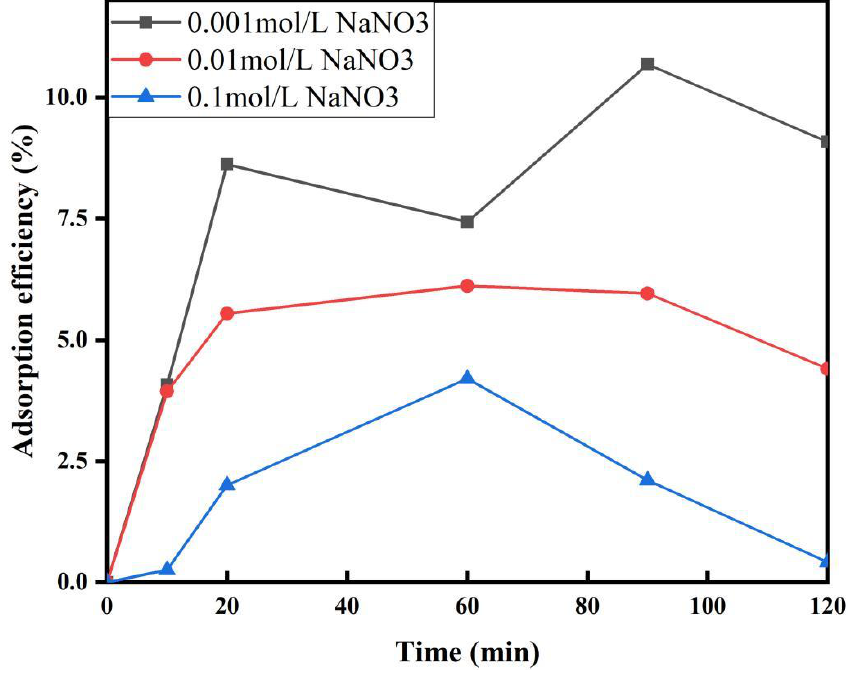
Figure 3. Effect of different ionic strength on the sorption of Sr on soil colloids. T = 25 ± 1 °C, C[Sr 2+ ] inital = 100 mg·L −1 , soil-liquid rate = 0.8 g·L −1 , pH = 6 ± 0.1. C[Sr 2+ ] · L − 1 , soil-liquid rate = 0.8 g · L − 1 , pH = 6 ± inital = 100 mg